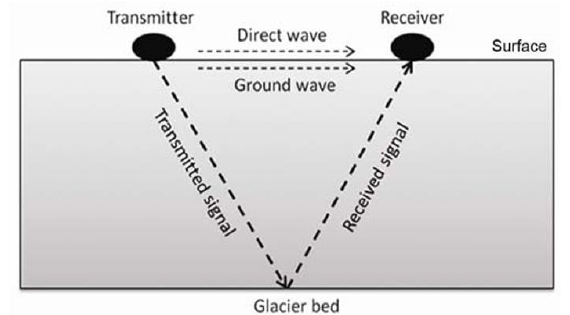
Figure 2. GPR operational principles. Figure is from Singh, 2012.